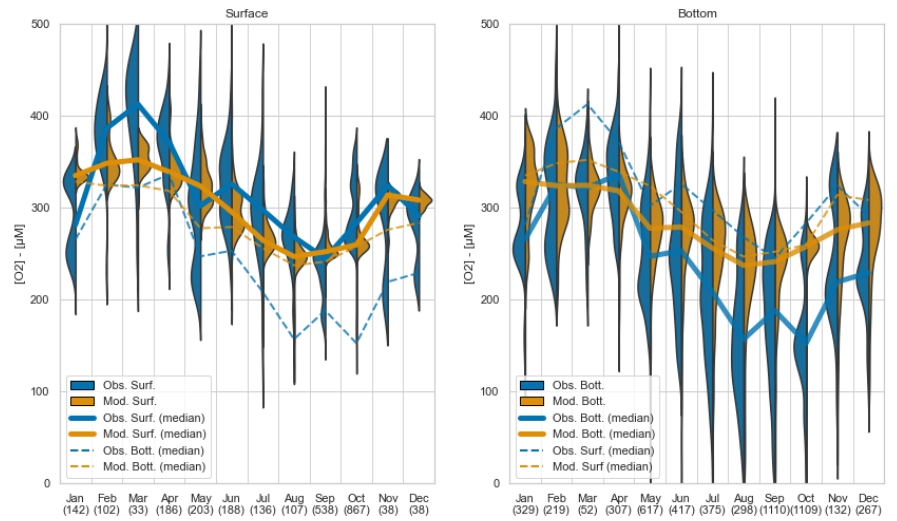
Figure 10. Seasonal cycle between 1992 and 2019 of the modelled (orange) and observed (blue) oxygen concentrations over the north-western shelf (at depths of 15–80 m) on the surface ( left ) and at the bottom ( right ). The number of observations for each month is reported along the X -axis.